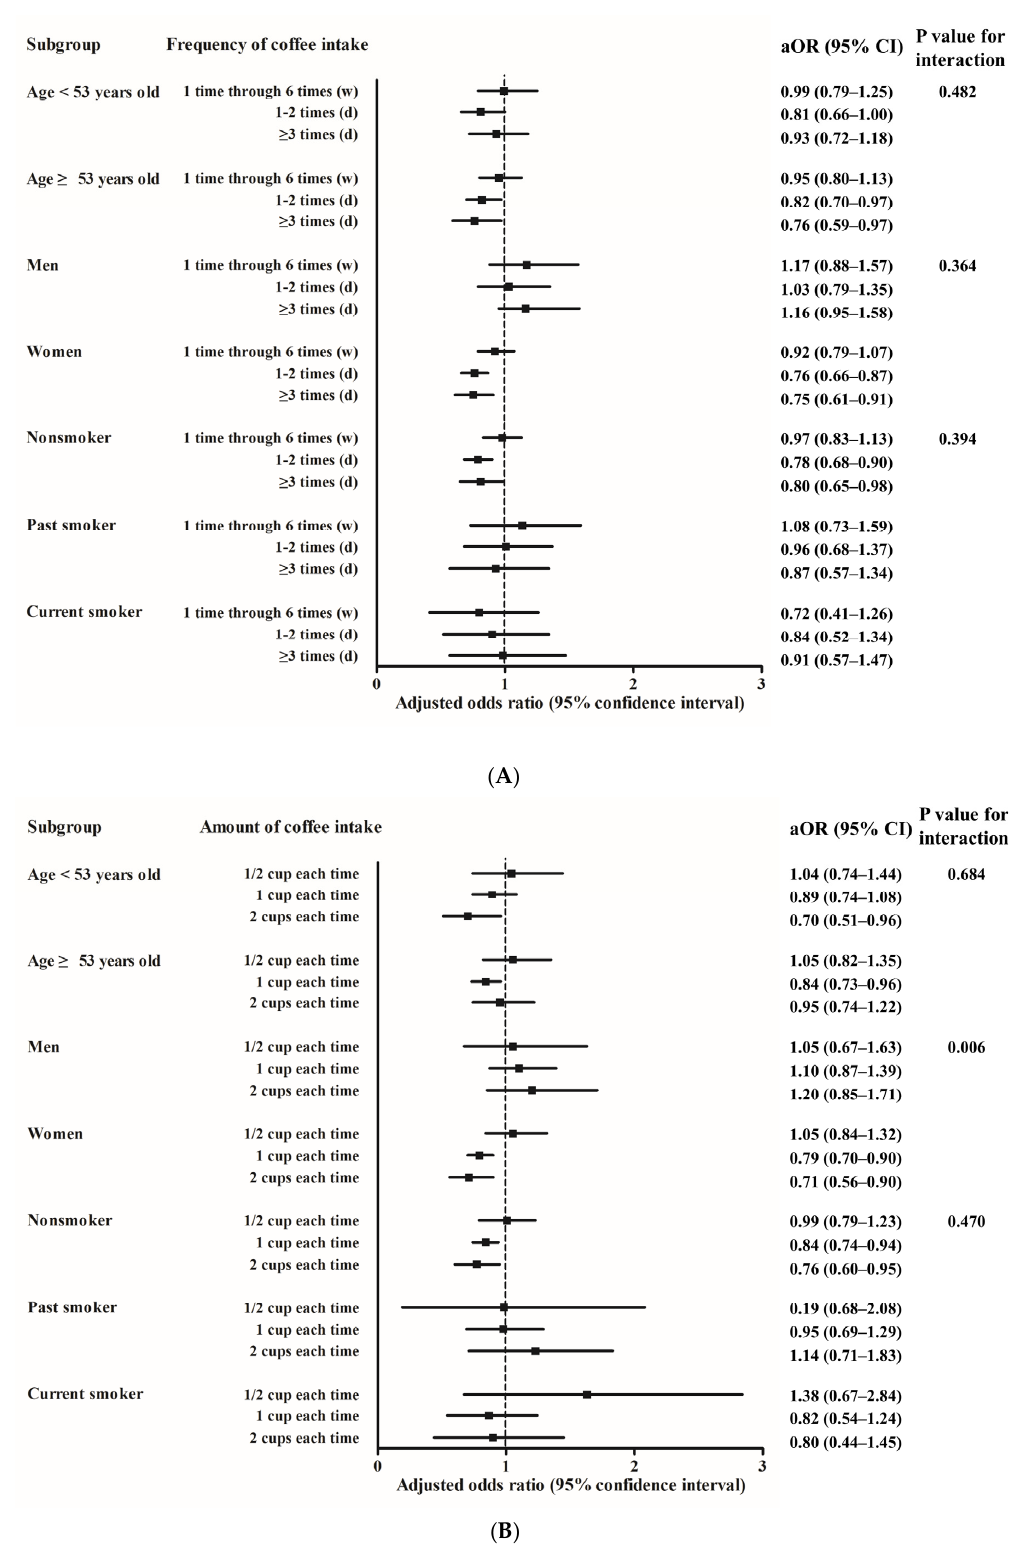
Figure 2. Subgroup analyses according to age, sex, and smoking status. Adjusted odds ratios (95% confidence interval) of coffee intake (( A ) frequency, ( B ) amount) for asthma based on multiple logistic regression analyses adjusted for age, sex, BMI category, income, smoking status, alcohol consumption, nutritional intake (total calories, protein, fat, and carbohydrate), and frequency or amount of green tea and soda drink intake.